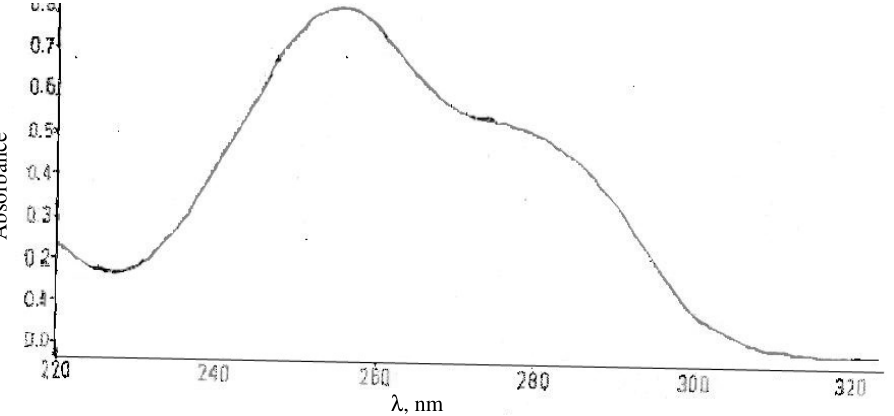
Figure 2. UV spectra of valacyclovir HCI.